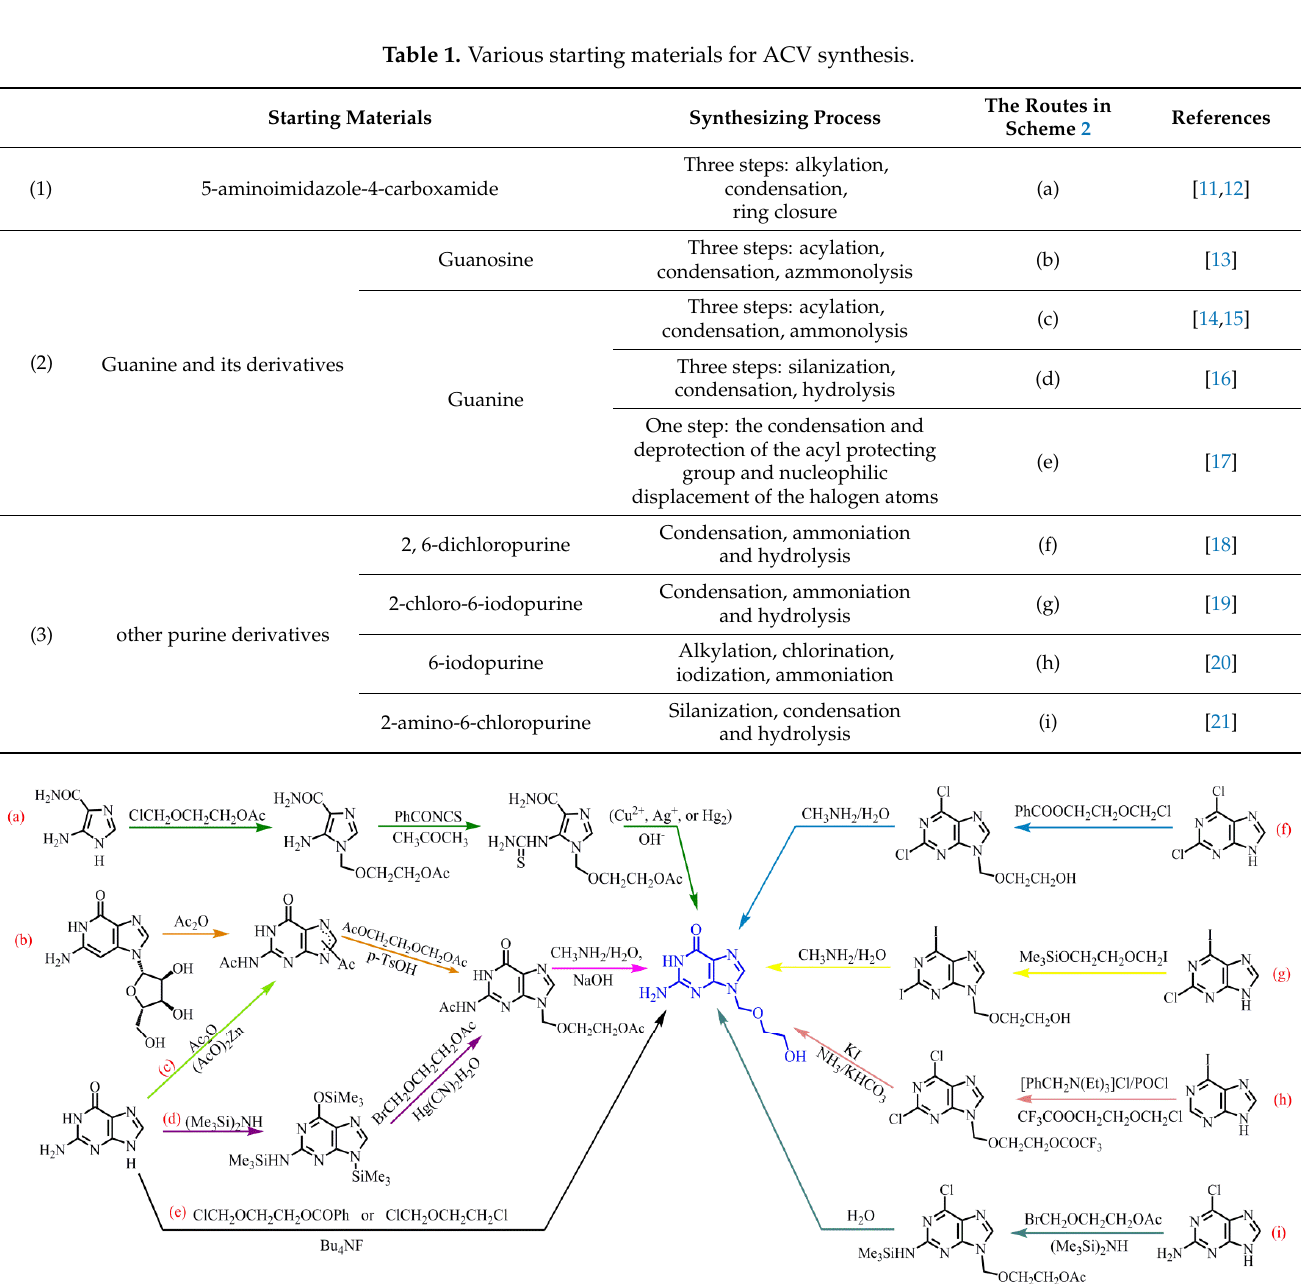
Table 1. Various starting materials for ACV synthesis.